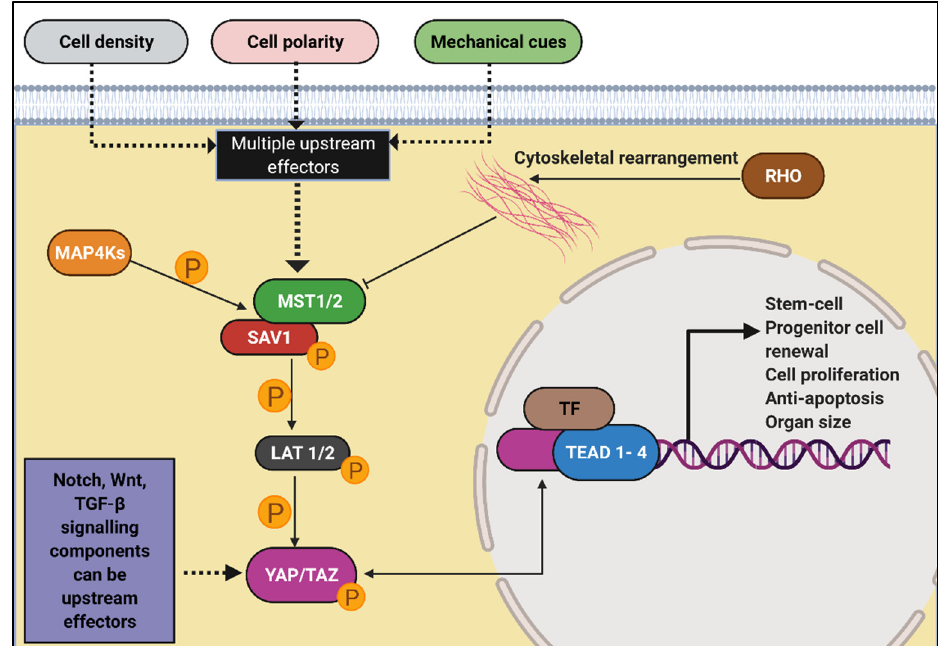
Figure 10. Key components of Hippo signalling upon activation: Various external stimuli (cell density, polarity, mechanical cues) and/or upstream cellular signals (mitogen-activated protein kinase (MAPK), RHO mediated signaling) can trigger the Hippo pathway. Upon activation, salvador family WW domain containing protein 1 (SAV1), macrophage stimulating 1/2 (MST1/2) interact to form a complex. This phosphorylates large neutral amino acids transporter small subunit 1/2 (LAT1/2) which in turn activates transcription co-activators yes-associated protein (YAP) and tafazzin (TAZ). Phosphorylated YAP/TAZ translocates to the nucleus and interacts with TEA domain transcription factor 1-4 (TEAD1-4) and other transcription factors to regulate the expression of Hippo pathway (Modified and redrawn using BioRender.com [290,291] ).